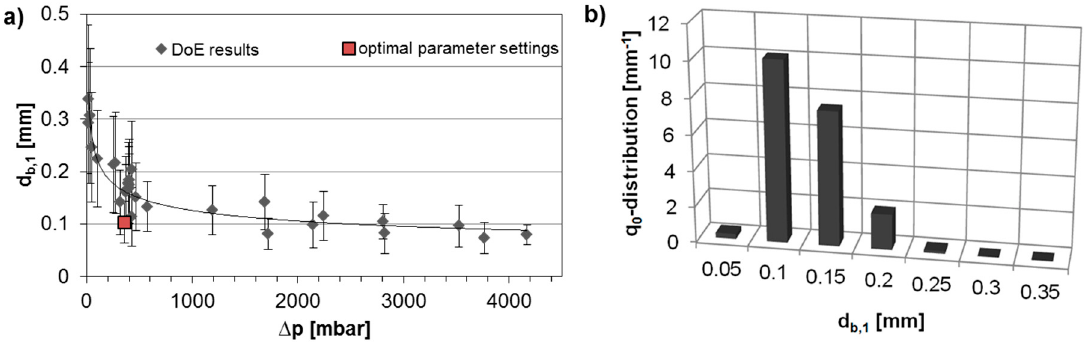
Figure 22. ( a ) Mean daughter bubble diameter in dependence of the nozzle induced pressure drop including DoE results and the experimental point for the optimal parameter settings; ( b ) bubble size density distribution for optimal parameter settings experiment.